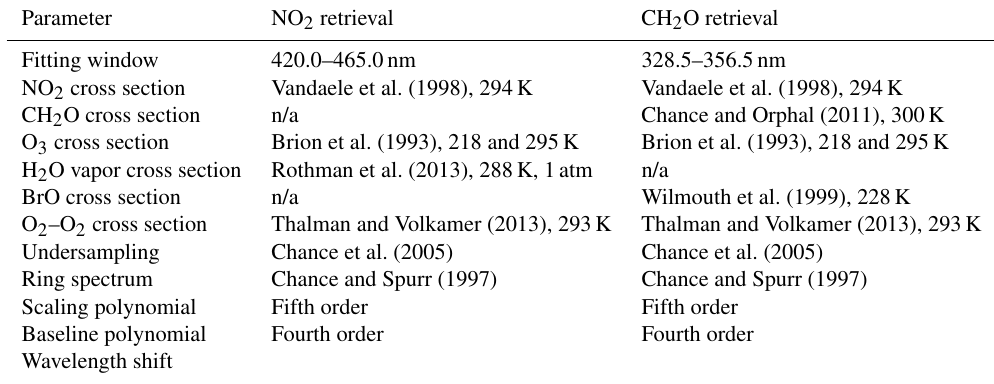
Table 3. Fitting details and fitted parameters used in GCAS trace gas retrievals. “n/a” means not